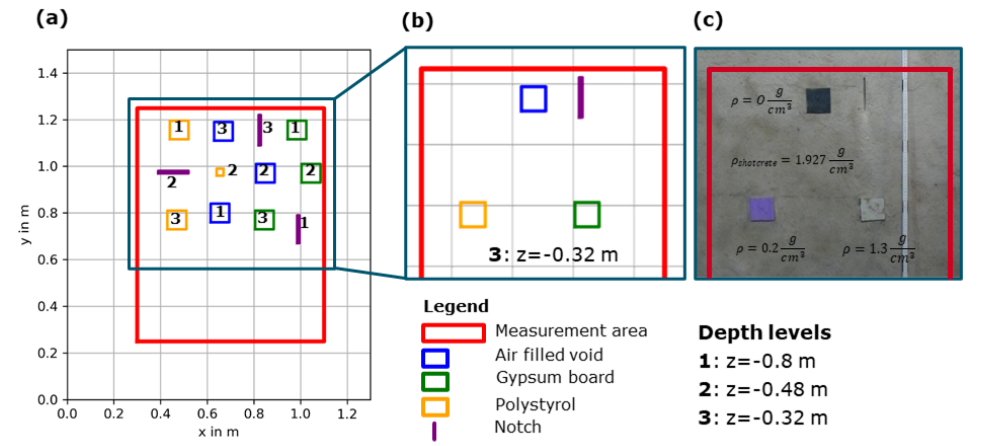
Figure 8. Experimental setup for GSBV4, including artifical defects: ( a ) Overview of all incorporated defects; ( b ) defects at the specific depth slice z = 0.32 m; ( c ) photo of the defects during construction at the same depth slice.